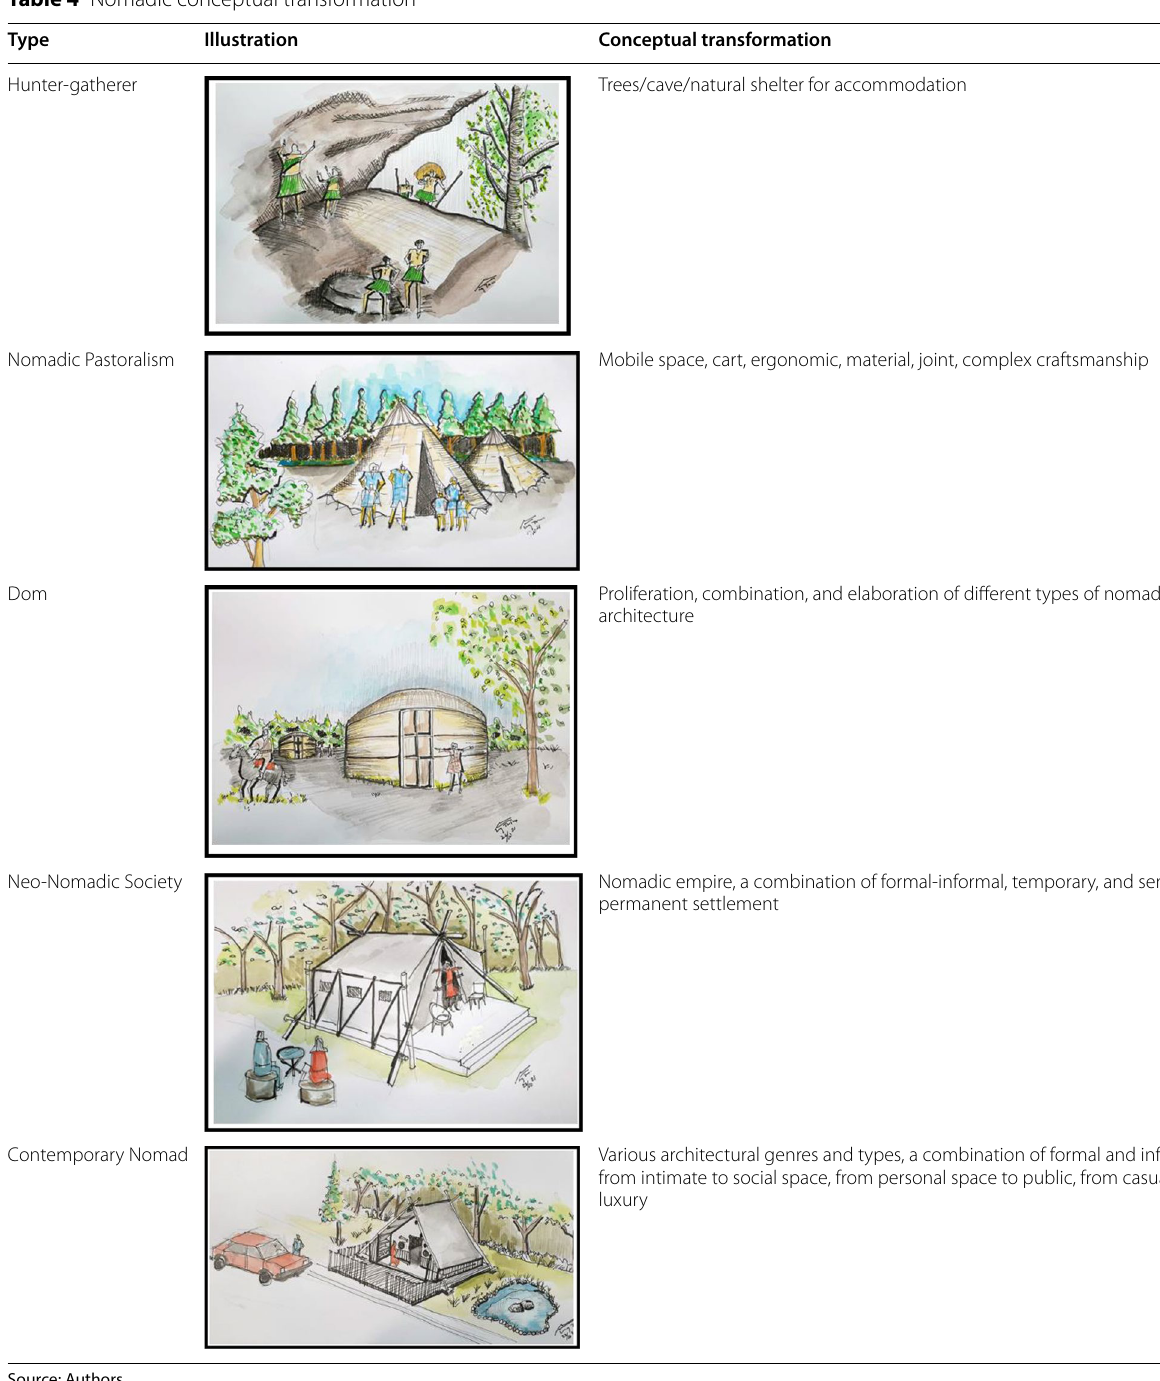
Table 4 Nomadic conceptual